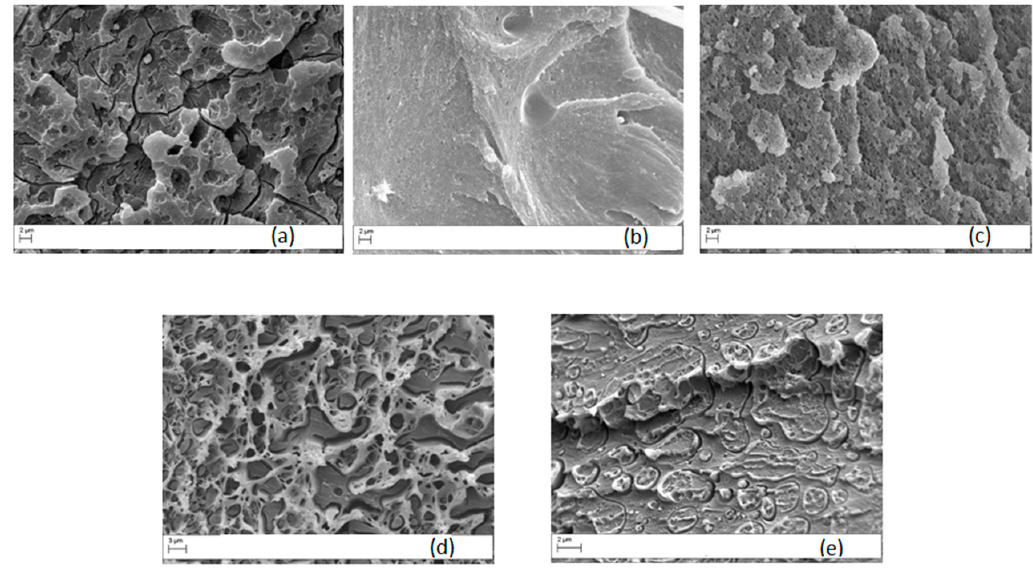
Figure 12. Micrographs of crio-fractured PEI/PC blends for different PC content (magnification 10,000×): ( a ) 5 wt %; ( b ) 10 wt % ; ( c ) 20 wt % ; ( d ) 30 wt % ; ( e ) 40 wt %.